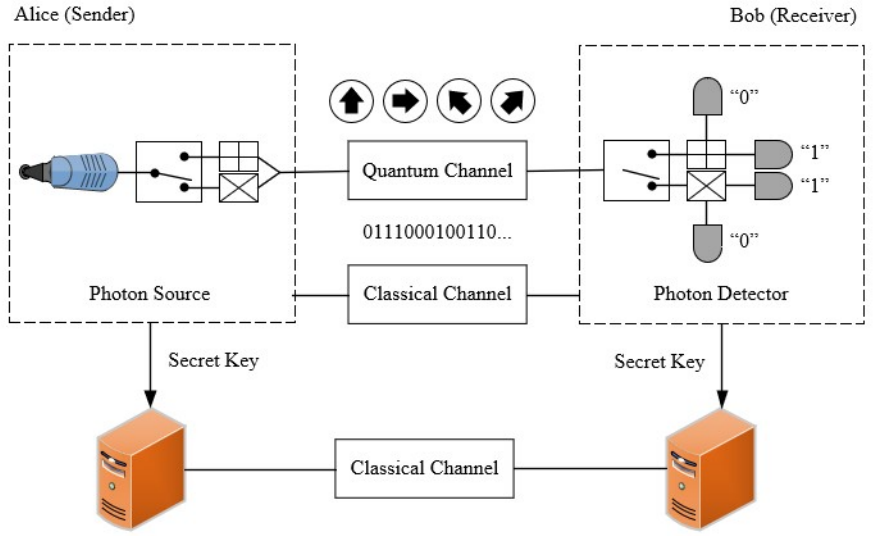
Figure 1. Classical QKD Mechanism (Polarization ‐ encoding BB84 protocol) .